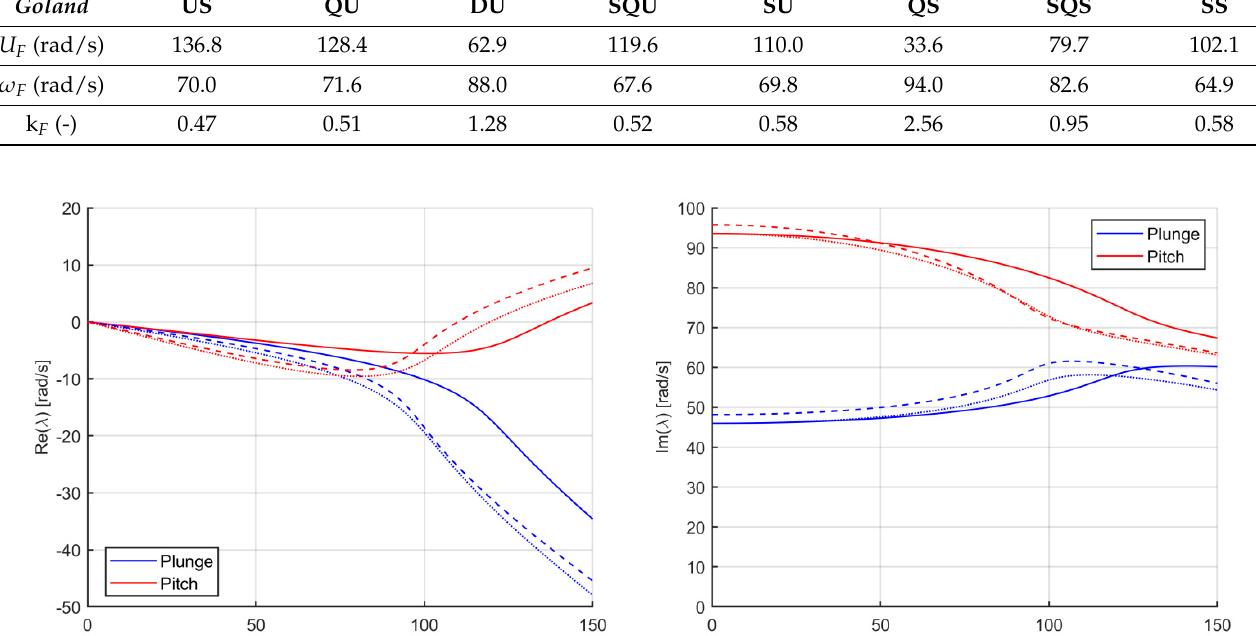
Figure 9. Evolution of the complex eigenvalues for Goland’s wing: real part ( left ), imaginary part ( right ); continuous, dashed and dotted lines for US, SU and SQU aerodynamic models, respectively.